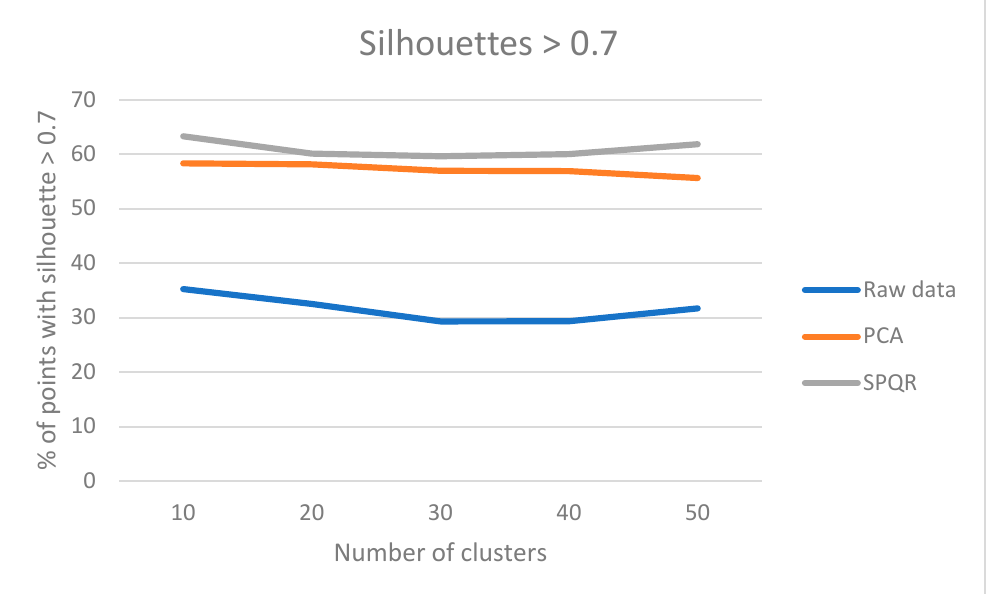
Figure 1. Mean results in terms of silhouettes >0.7 obtained by varying the number of clusters from 10 to 50.